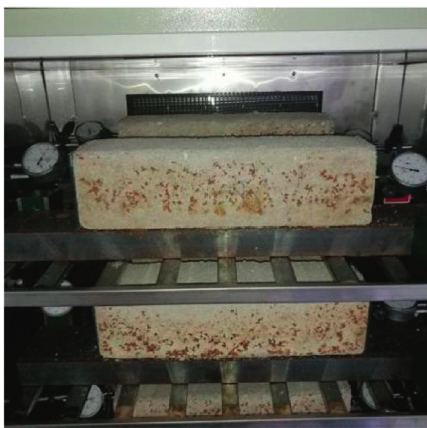
Figure 2: Dry shrink